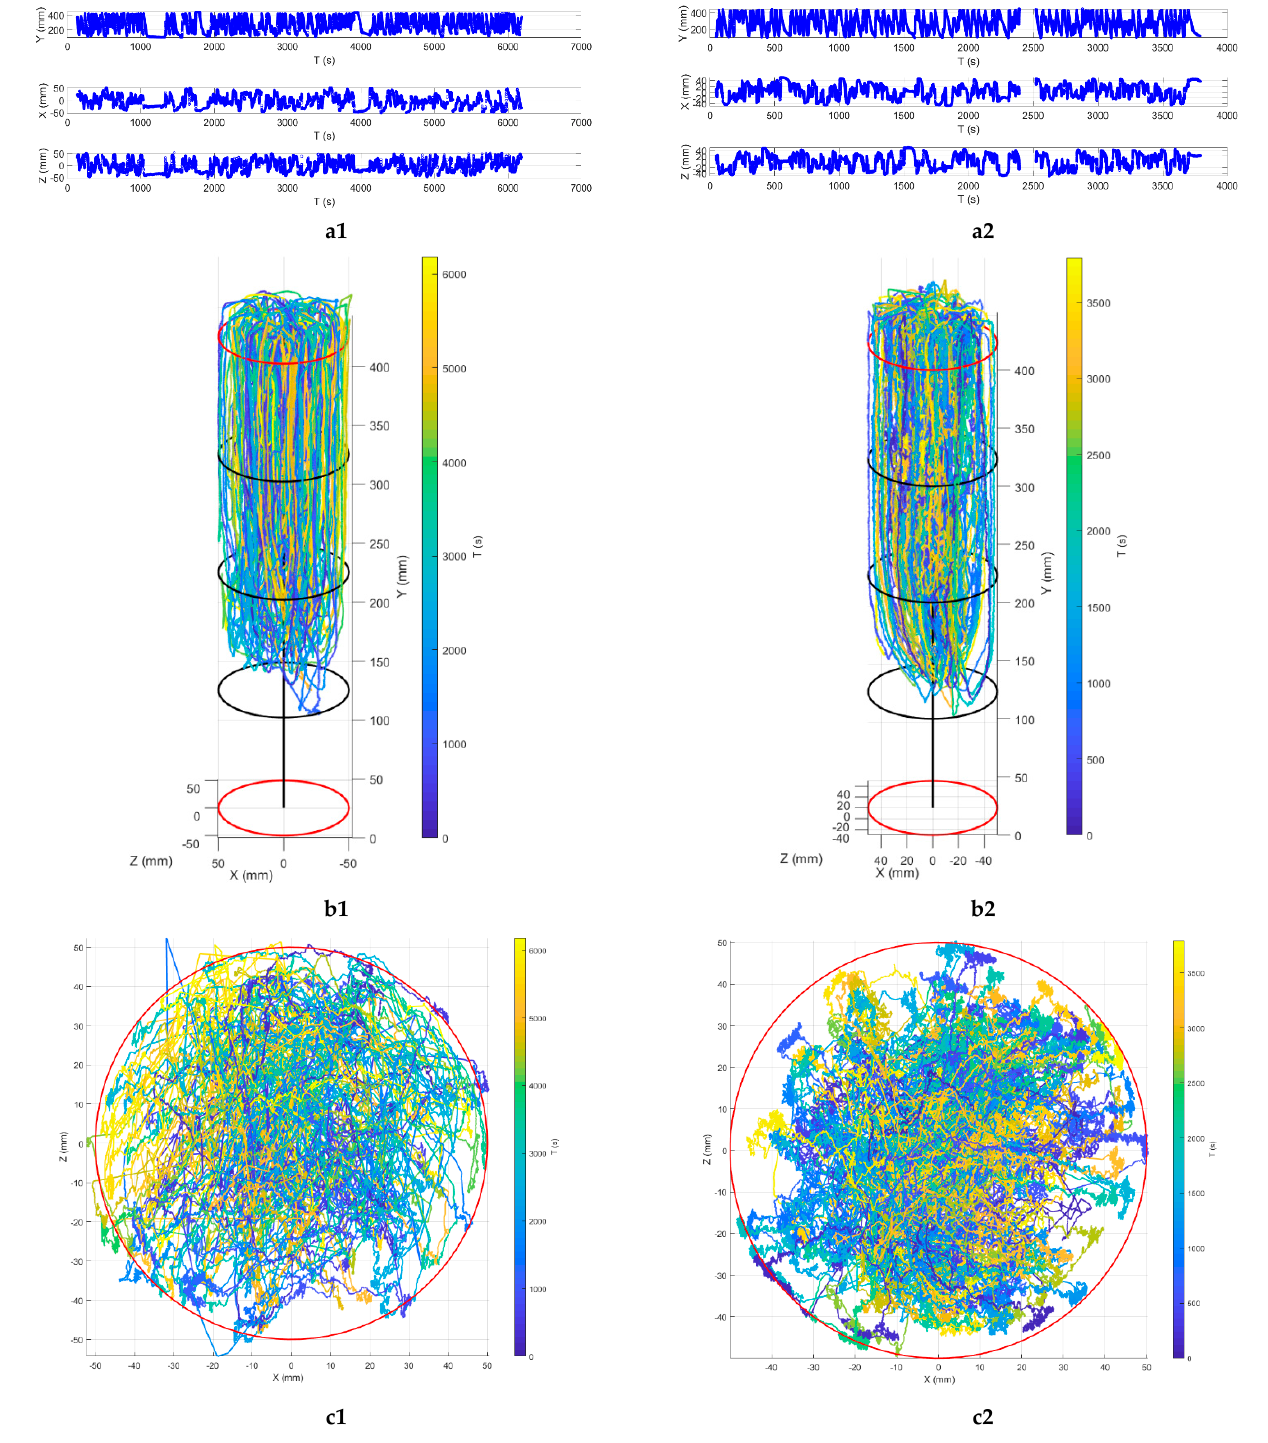
Figure A3. Trajectories of an activated quartz particle ( − 150 + 106 µm) inside the bed against time for 1.25 u mf (1) and 1.50 u mf (2): ( a ) the tracer trajectory with fit; the tracer trajectory from side view ( b ) and top view ( c ).